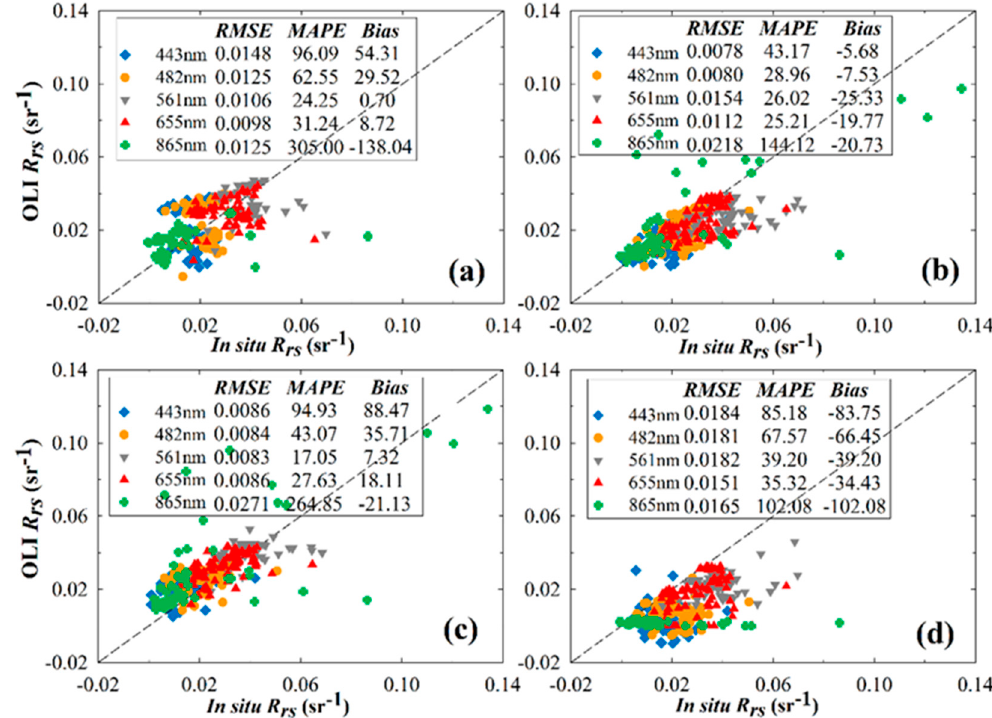
Figure 4. Scatter plots of R rs retrieved by the water-AC algorithms (SWIR ( a ), EXP ( b ), DSF ( c ), and MUMM ( d )) versus in situ R rs MUMM ( d )) versus in situ R rs .